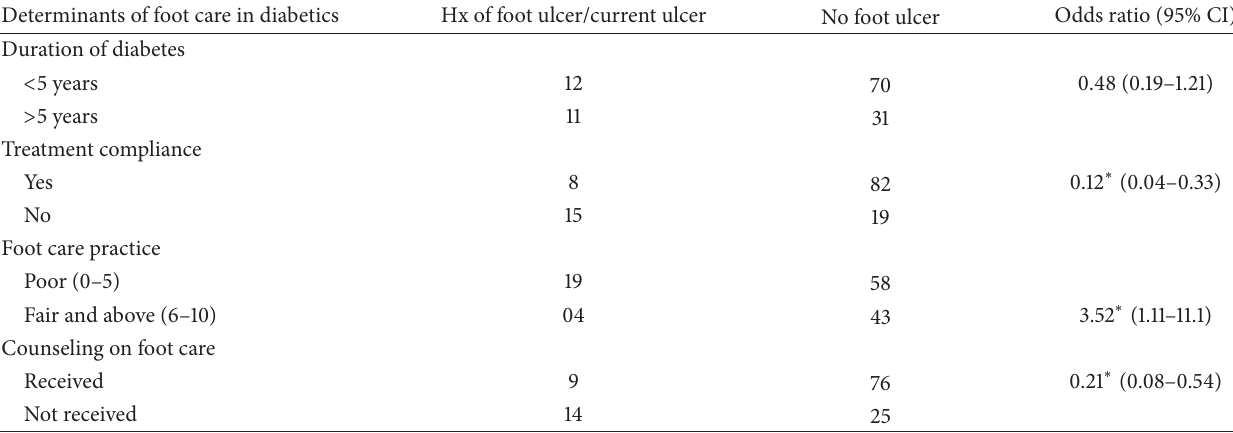
Table 3: Possible determinants of foot ulcer in diabetics.